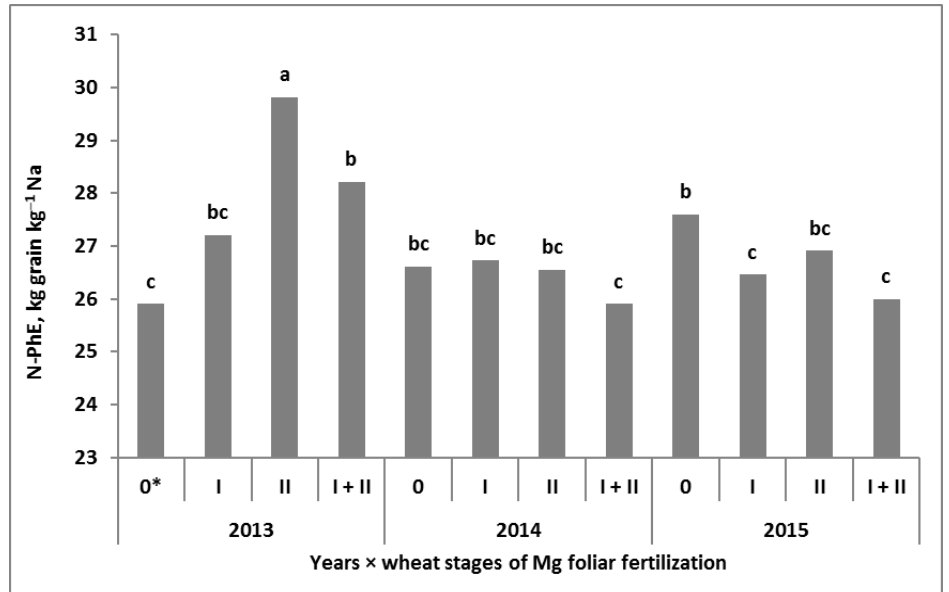
Figure 6. Effect of winter wheat foliar fertilization with magnesium on nitrogen physiological efficiency. a, b, c Similar letters mean a lack of significant differences using Tukey’s test. Mgf— foliar Mg fertilization system. * Stages of Mg foliar fertilization to wheat: I — BBCH30; II — BBCH 49/50.